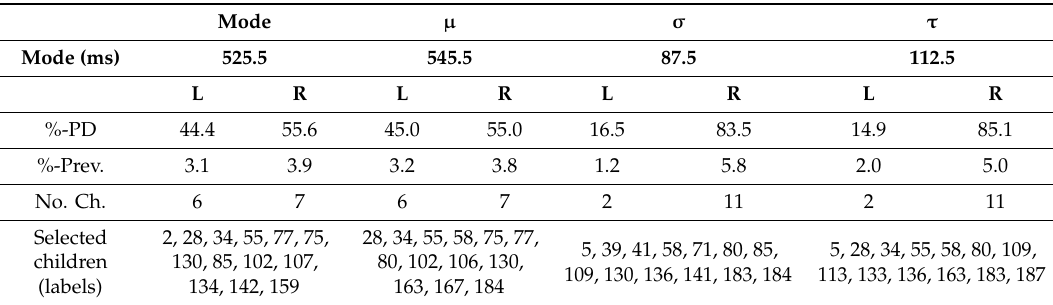
Figure 5. Probability distributions of the mode ( a ) and of µ parameter in an ex-Gaussian representation of the data ( b ). Table 1. Results of the classification for the distribution of the mode, µ , σ and τ (columns from second to fifth) taking into account a 7% of world prevalence of ADHD in school-aged children. The rows show the mode, the probability percentages at both sides of the mode (%-PD), the splitting of the prevalence percentage (%-Prev.), corresponding number of children (No. Ch.), and the selected children in terms of